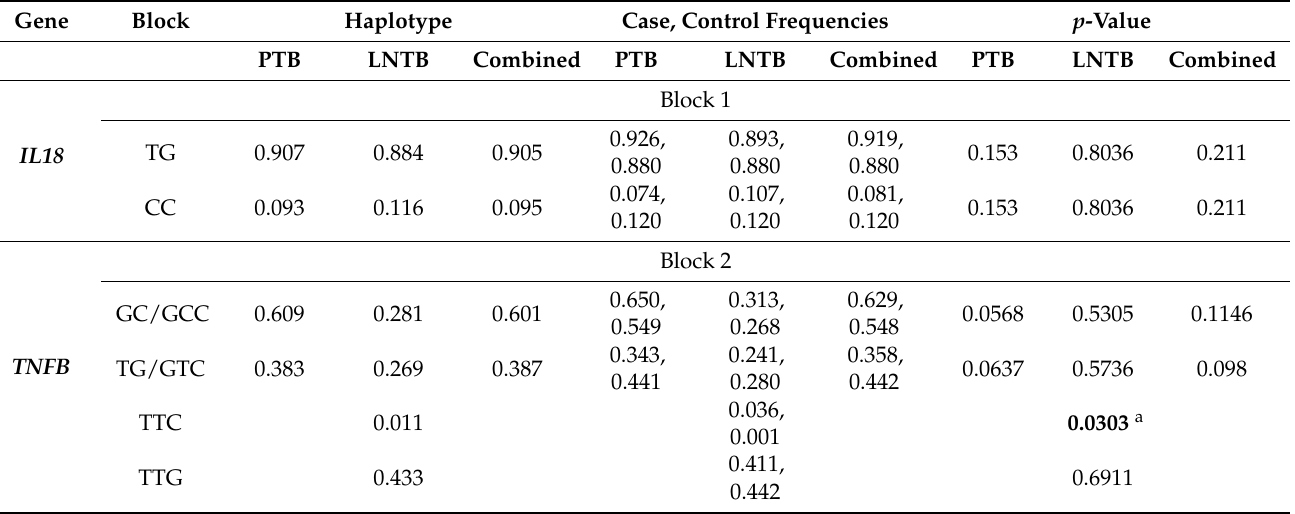
Table 2. Comparative Haplotypic association statistics of cytokine variants in the discovery group between PTB and